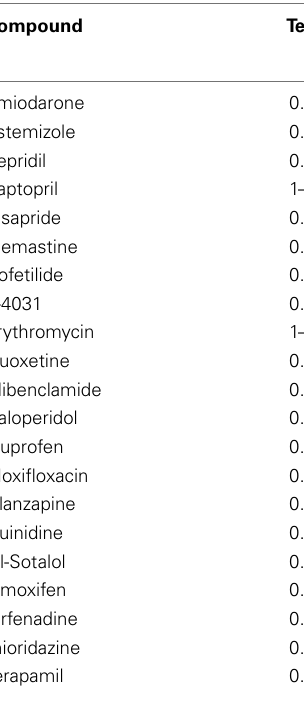
Table 2 | Effects of reference drugs on the hERG K +